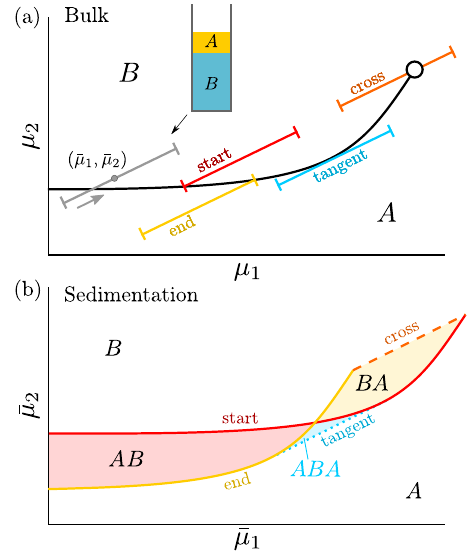
Fig. 2 Sedimentation path theory. a Model bulk phase diagram in the plane of chemical potentials μ 1 − μ 2 . Phases A and B coexist along a binodal (solid line) that ends at a critical point (empty circle). The line segments are sedimentation paths. The gray path that crosses the binodal corresponds to a stacking sequence AB (from top to bottom), as schematically represented. The gray arrow indicates the direction of the paths from top to bottom of the sample. Examples of all types of paths that form the boundaries between different stacking sequences are shown: (i) paths that either start (red) or end (yellow) at the binodal, (ii) paths tangent (blue) to the binodal, and (iii) paths crossing (orange) the critical point. An in fi nitesimal displacement of any of such paths can alter the stacking sequence. b Corresponding stacking diagram in the plane of average chemical potentials (cid:1) μ (cid:3) (cid:1) μ . Each colored region is a different stacking 1 2 sequence, as indicated. The boundary lines between sequences are sedimentation binodals of type I (solid lines) or type II (dotted-blue line), and terminal lines (dashed-orange see Fig. 2a. The fi rst type corresponds to sedimentation paths that either start or end at a bulk binodal (red and yellow paths in